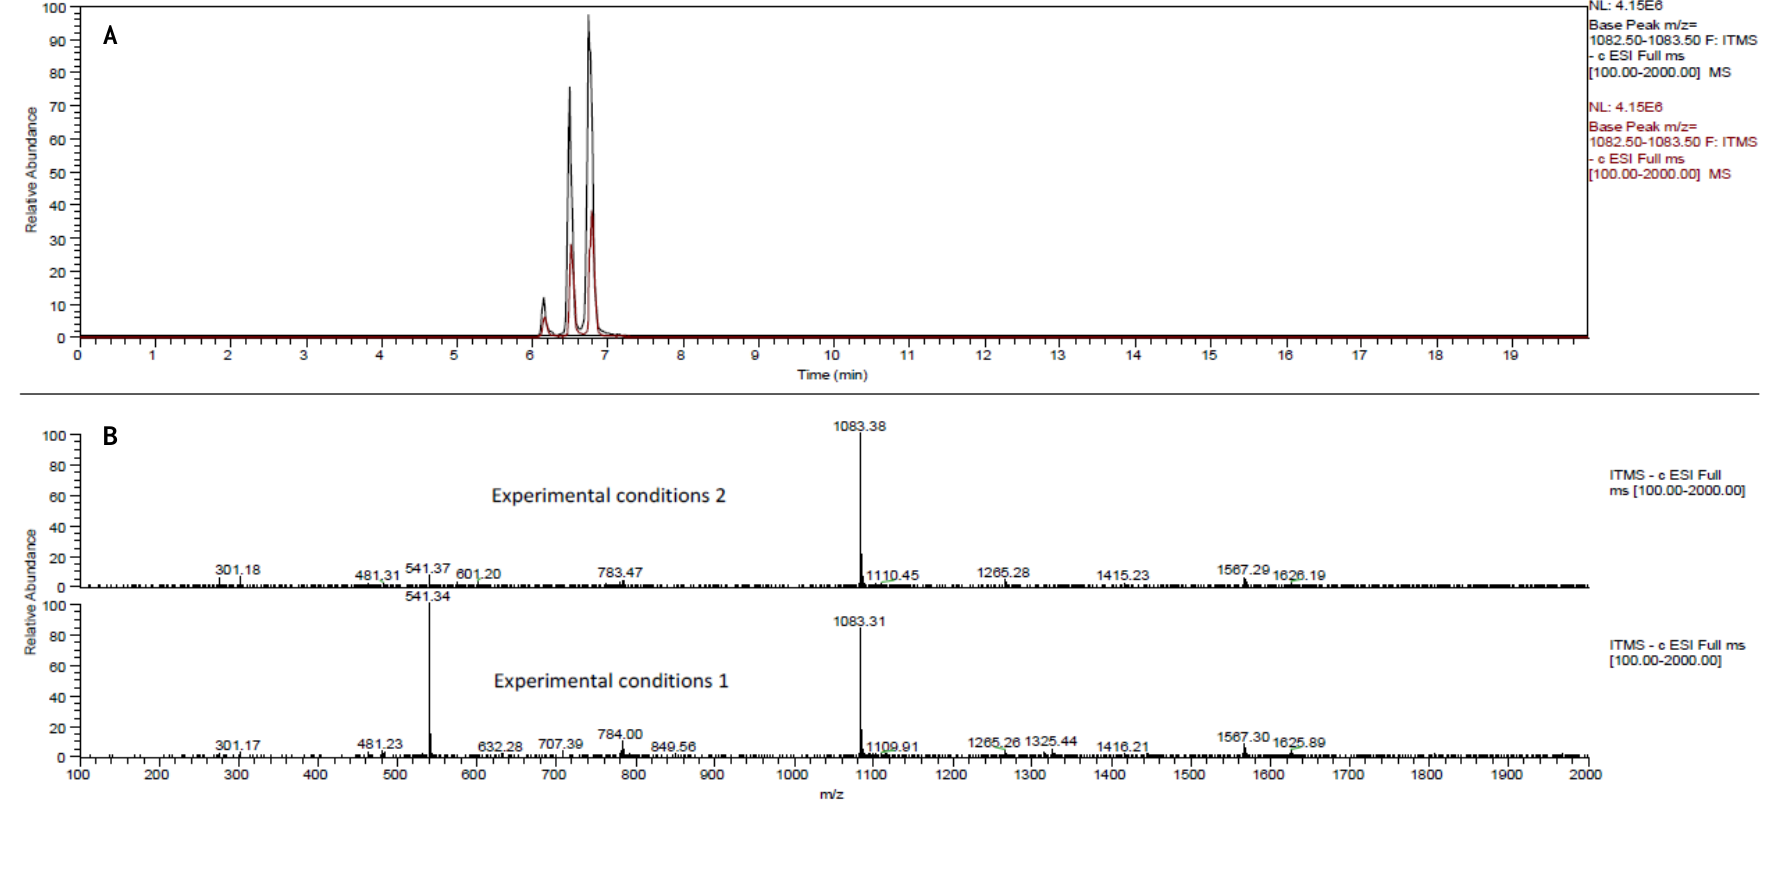
Figure 2. ( A ) Chromatograms of punicalagin isomer ( 70 ), α-punicalagin ( 42 ) and β-punicalagin ( 43 ) in Full MS scan ( m/z 1083) for pomegranate juice analyzed by BlueOrchid C18 column. Comparison of the two different analytical conditions: experimental conditions 1 (brown peaks) and experimental conditions 2 (black peaks). ( B ) MS spectra of α- and β-punicalagin using the two experimental conditions. A